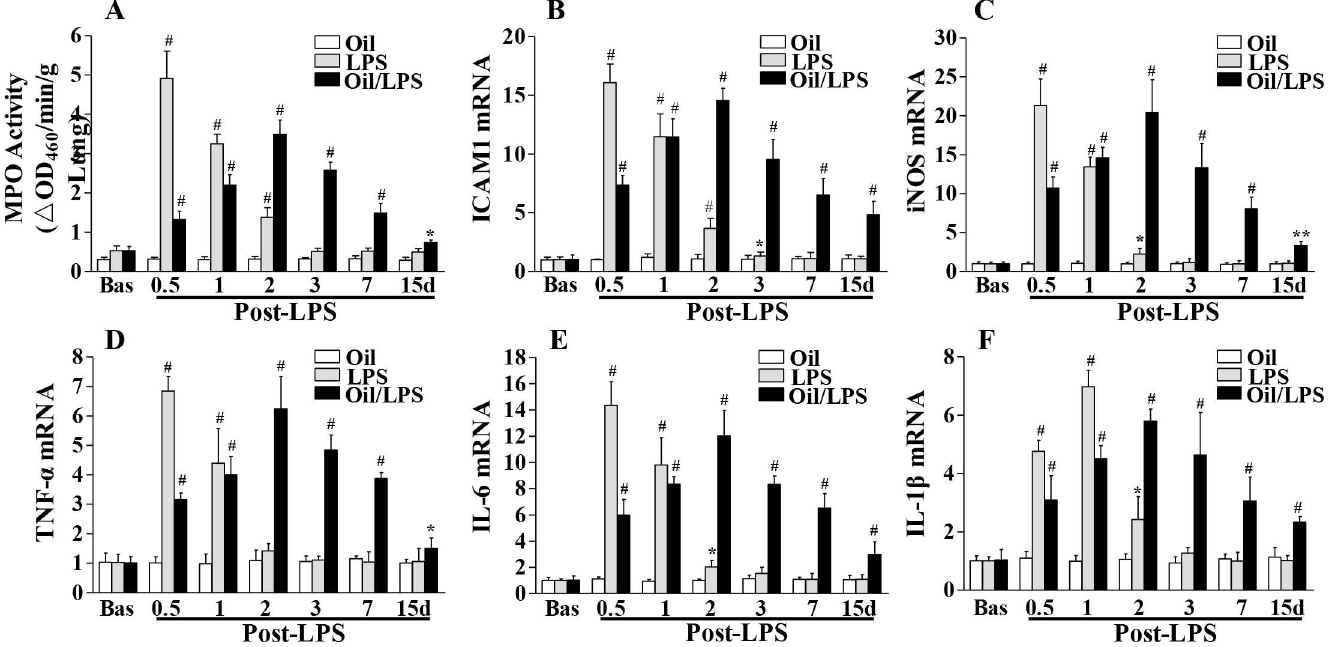
Fig 2. Extended course of lung inflammation and subsequent resolution in corn oil/LPS-treated mice. ( A ) Time course of lung MPO activity. At indicatedtimes, lungs were collectedafter PBS perfusionfree of blood for MPO activity assay. ( B - F ) QRT-PCR analysesof expressionof proinflammatory genesin mouse lungs. The elevated expressionof proinflammatory genes in oil-free mice decreased to basal levels at 3 days post-LPS challenge whereasit remained elevated at 15 days post-LPS in oil/LPS-challengedmice. Corn oil administration without LPS challengedidn’tinduce any inflammatory response. All data are expressedas mean ± SD (n = 4/group). * , P < 0.05; ** , P < 0.01; #, P < 0.001 versus basal with or without oil, respectively.